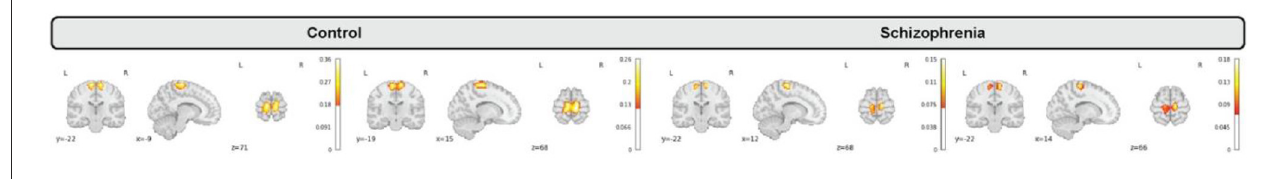
FIGURE3 Generated maps for a sensori-motor (SM3) network for a random subset of subjects including control (2 left) and schizophrenia (2 right) that vary over subjects.